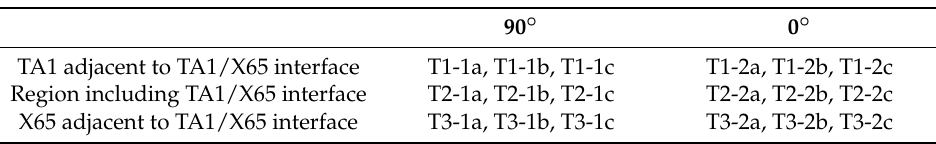
Figure 2. The specimen size and the sampling scheme of the tensile tests: ( a ) specimen size; ( b ) 90°; and ( c ) 0°. Table 3. List of sample numbers in tensile tests (repeated three times).